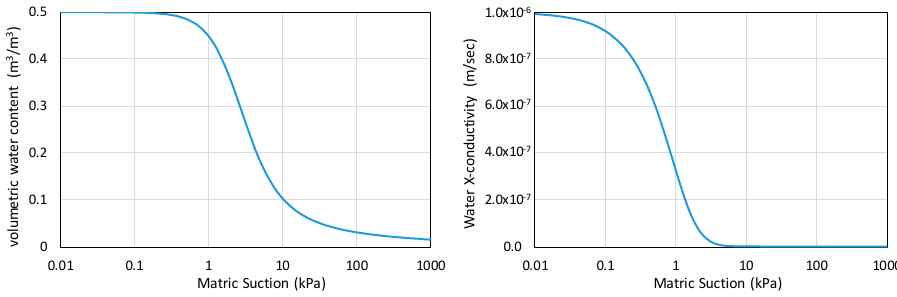
Figure 9. Water conductivity vs. matrix suction and water content vs. matrix suction.